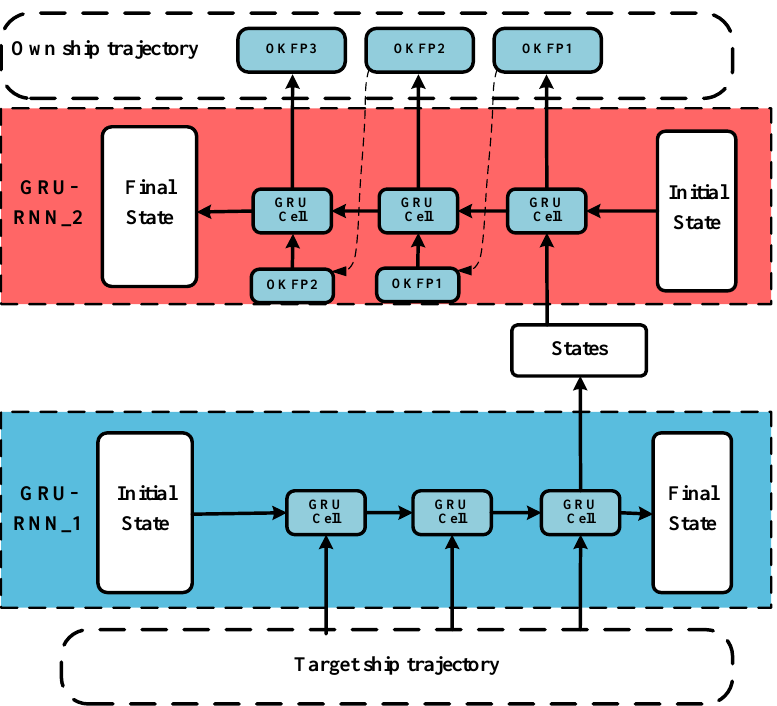
Figure 17. Double GRU-RNN training diagram.